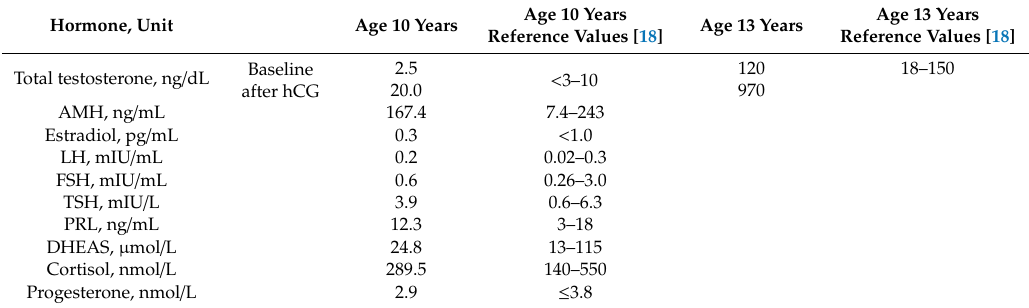
Table 1. Values of testosterone (baseline and after human chorionic gonadotropin (hCG) stimulation), anti-Müllerian hormone (AMH), estradiol, luteinizing hormone (LH), follicle-stimulating hormone (FSH), thyroid-stimulating hormone (TSH), prolactin (PRL), dehydroepiandrosterone sulfate (DHEAS), cortisol, and progesterone of the partial androgen insensitivity syndrome (PAIS) patient. Hormone, Unit Age 10 Years Total testosterone, ng /